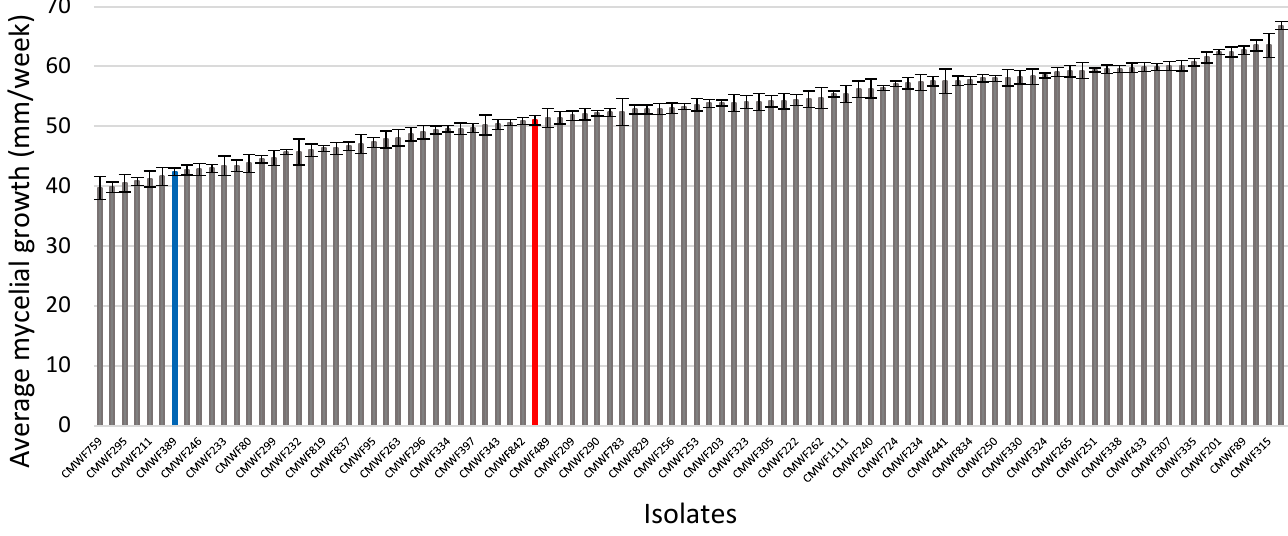
Figure 1. Mycelial growth differences between F. circinatum FSP34 ( red ), F. temperatum ( blue ), and the F 1 progeny were observed after 7-day growth on PMEA (pine-tissue extract containing malt extract agar) growth medium. The error bars represent the standard